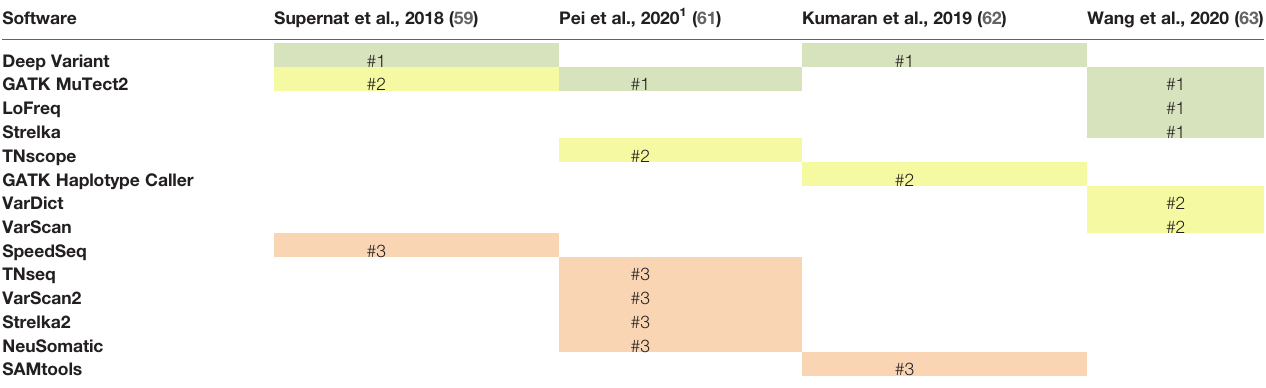
TABLE 2 | Comparison of the ranking of insertion and deletion (indel) callers across four benchmarking studies that have been released since 2017. Software